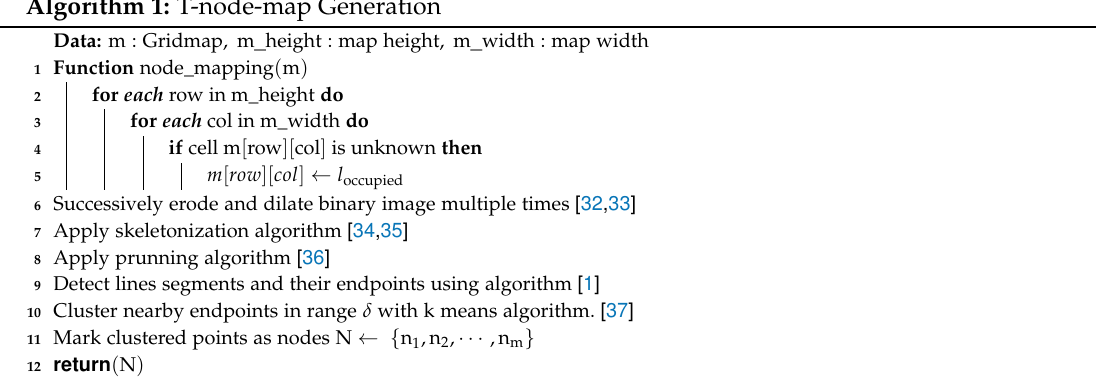
Algorithm 1: T-node-map